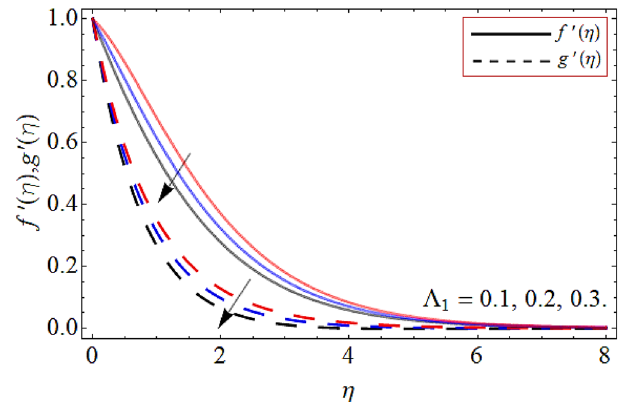
Figure 8. Velocity profile versus ratio of relaxation time to retardation term (cid:31) 1 .